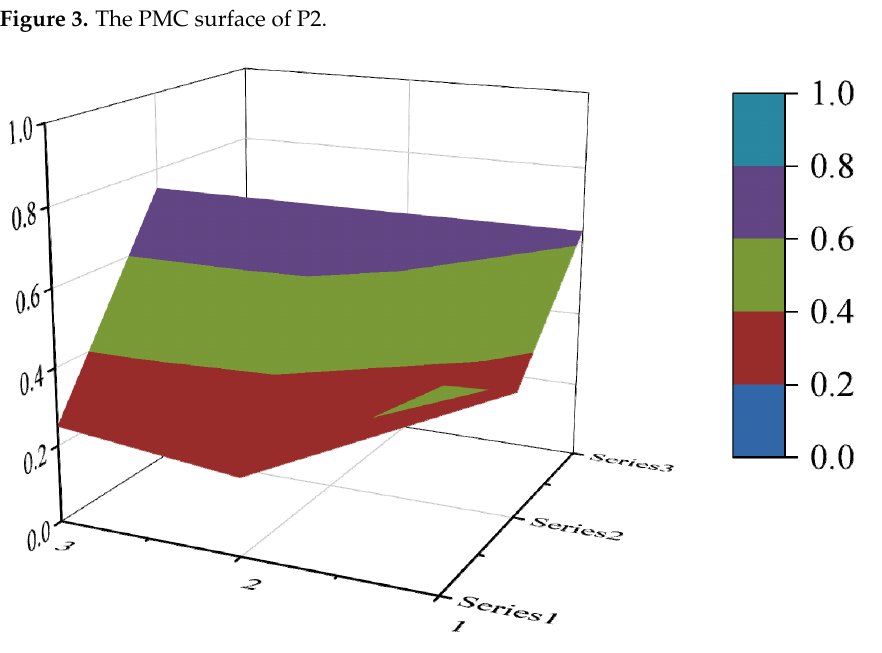
Figure 4. The PMC surface of P3.